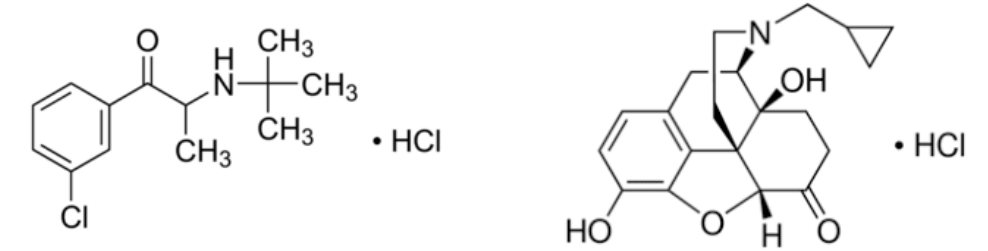
Figure 1. Chemical structures of racemic bupropion hydrochloride ( left ) and naltrexone hydrochlo- ride ( right ).